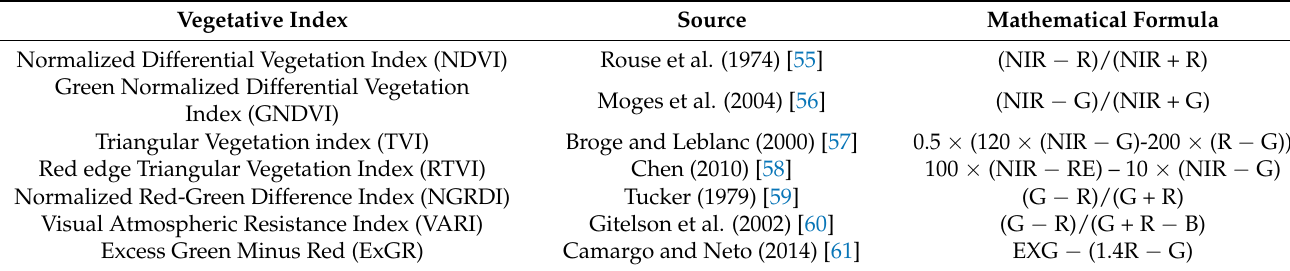
Table 1. List of spectral vegetation indices